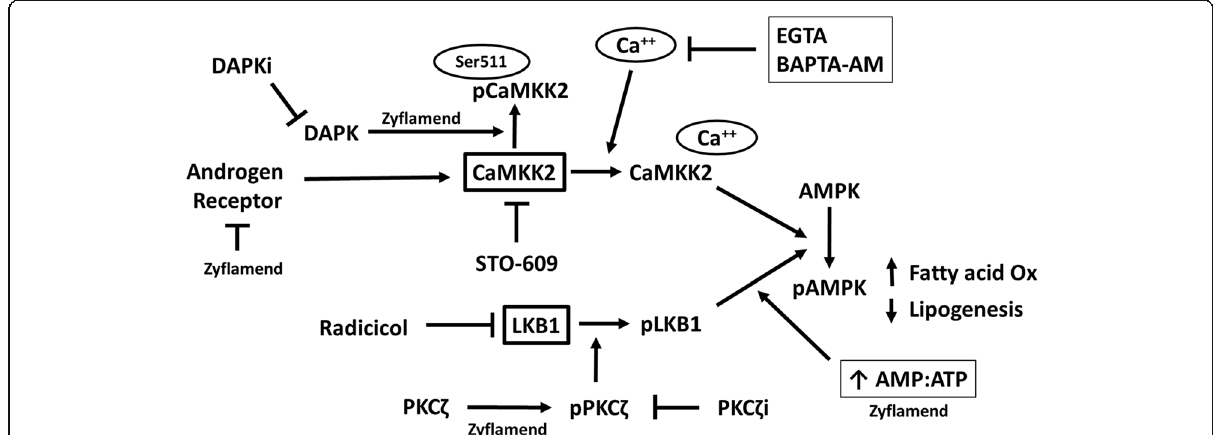
Fig. 8 Summary of the effects of Zyflamend on AMPK regulation by signaling pathways of LKB1 and CaMKK2. Zyflamend has been shown to inhibit castrate-resistant prostate cancer, in part, through the activation of AMPK. This activation is mediated by the increase in AMP:ATP ratio and the activation of the tumor suppressor protein LKB1 following phosphorylation by PKC ζ . Simultaneously, Zyflamend inhibits the tumor promotor CaMKK2 via phosphorylation at Ser511 by